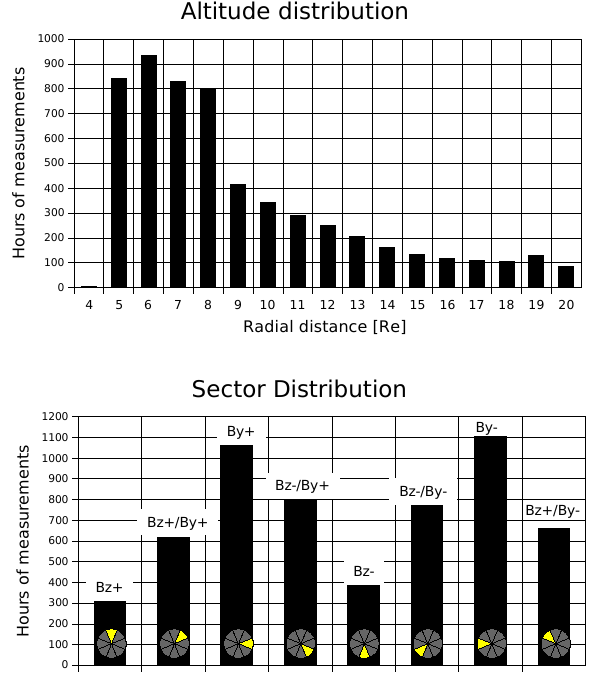
Fig. 1. Top panel: distribution of the EDI measurements versus geocentric radial distance. Most of the EDI measurements are taken at distances between 4 and 8 R E . The drop-off beyond 8 R E is due to constraints on EDI operations to avoid interference with the wave experiment onboard Cluster. Bottom panel: distribution of the IMF clock-angle for the EDI measurements used in this study. The two peaks represent the average IMF directions along the Parker spiral.